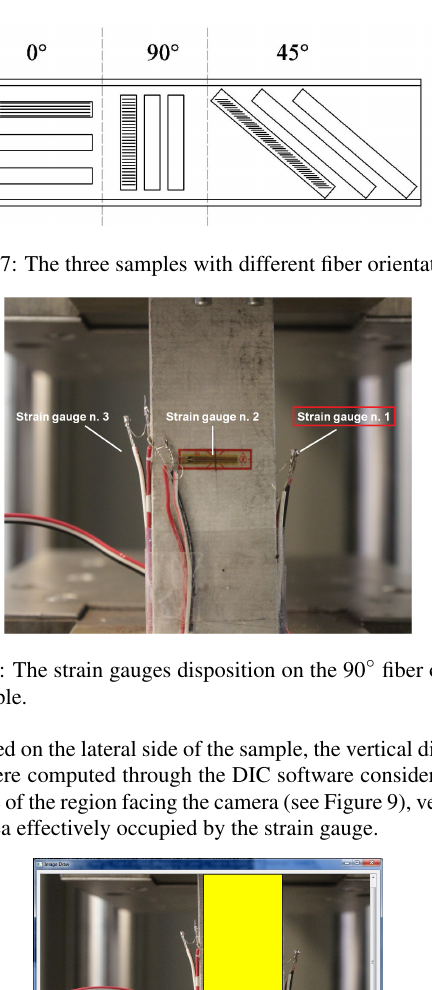
points located near the extremities of the strain gauge were con- sidered for the subsequent analysis: they were spatially averaged,